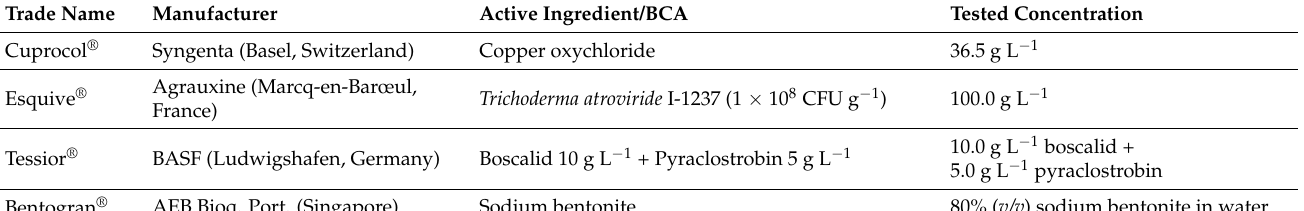
Table 1. Pruning wound protection products applied to three-day-old pruning wounds.